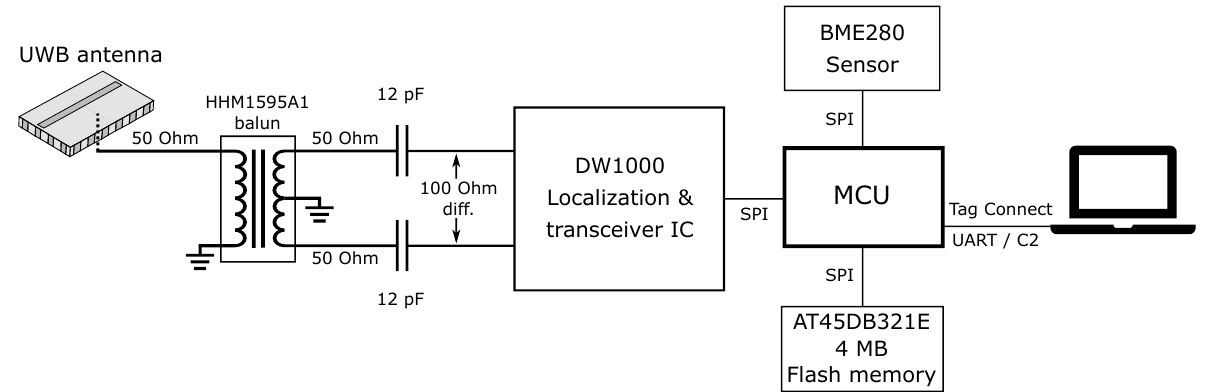
Figure 1. System architecture of the sensor system. The radio-frequency (RF) path of the signal from the antenna towards the localization Integrated Circuit (IC) is elaborated in